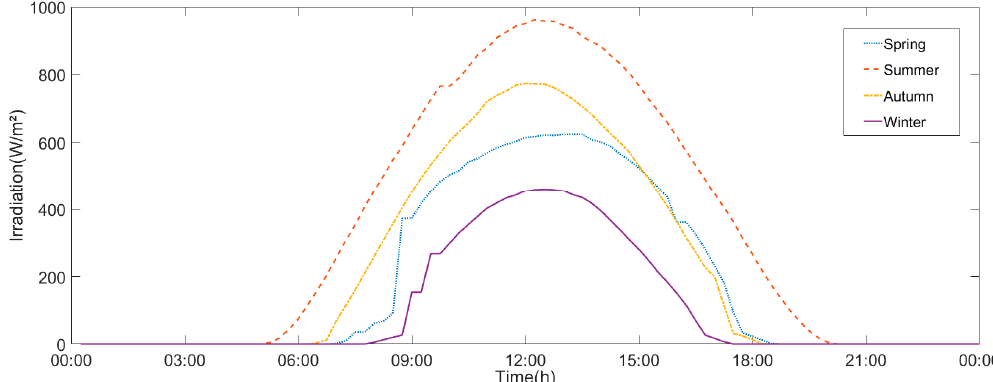
Figure 7. The four seasons’ periods over diurnal variations in irradiance (spring: 12.3 h; summer: 14.7 h; autumn: 12.7 h; winter: 10.2 h).